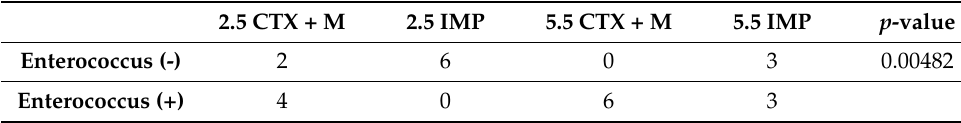
Figure 2. CFU in blood and spleen in severe IAI model. ( A ) CFU in blood, ( B ) CFU in spleen. * p < 0.05 compared with sham, ** p compared with CTX + M model. IAI, intraabdominal infection; CTX + M, ceftriaxone with metronidazole; IMP, imipenem; CFU, colony-forming unit. Table 1. Blood Cultures of Rats.